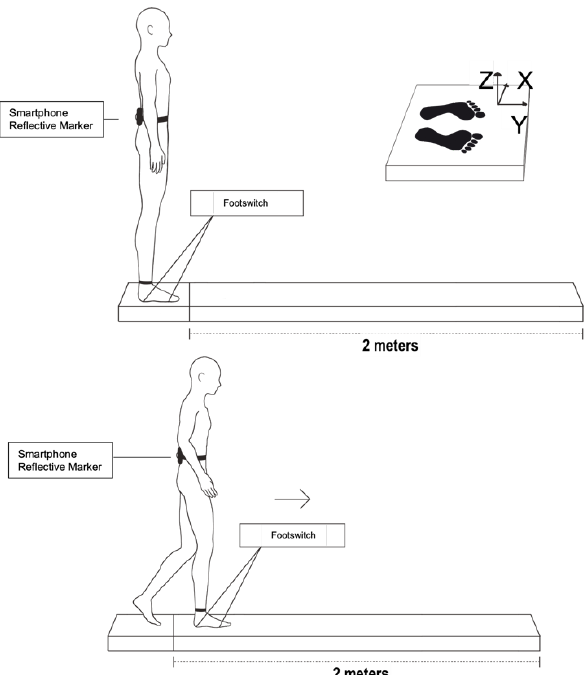
Figure 1. Subject standing on platform with cell phone and reflective marker at L5 and FSs at base of calcaneus and head of second metatarsal. Subject starting gait with right leg by 2-m walkway.